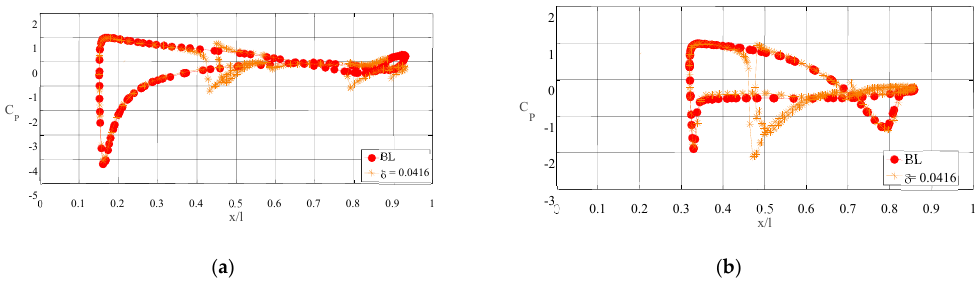
Figure 8. Pressure coefficient C p at ( a ) α = 40° and ( b ) α = 60° for δ = 0.0416 and x/l chosen as the length of the airship.